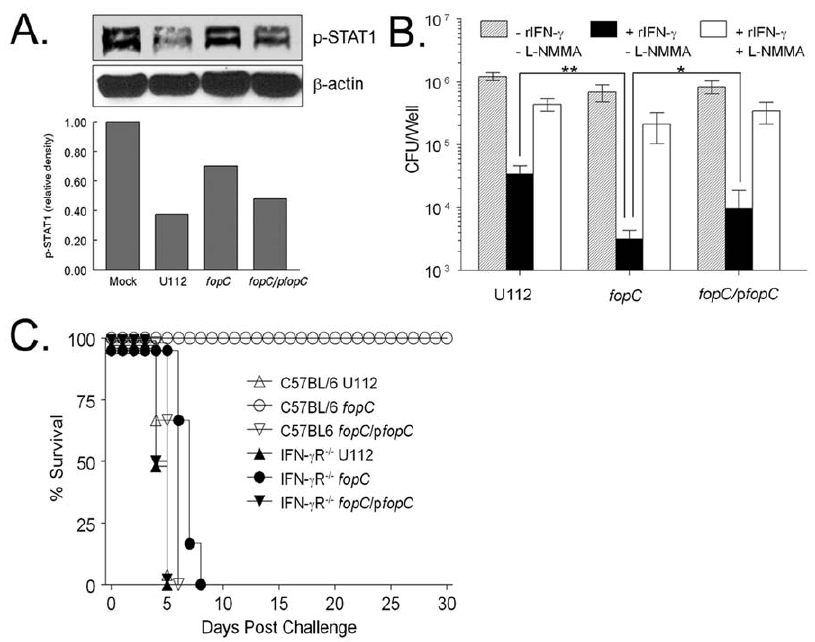
Figure 8. Virulence is restored in a fopC- complemented strain. (A) C57BL/6 macrophages (10 6 /well) were infected (10 MOI) with U112, fopC , or complemented fopC /p fopC strain in the presence or absence of rIFN- c (1 ng/ml) for 3 h. Protein-matched lysates from 3 h cultures were resolved by SDS PAGE and analyzed by Western blotting with phosphotyrosine-STAT1 and actin antibodies. The relative p-STAT1 levels of the three strains were first normalized with respective b -actin level and compared to mock treated p-STAT1. (B) Bone marrow derived primary macrophages (2 6 10 5 / well) from C57BL/6 or IFN- c R 2 / 2 mice were infected (10 MOI) with wildtype U112, fopC mutant or fopC /p fopC in the presence or absence of 1 ng/ml rIFN- c and 0.25 mM NOS inhibitor L-NMMA, and numbers of viable bacteria at 24 h determined by macrophage lysing and dilution plating. Results are expressed as the averages of values for three wells. Differences in bacterial replication within IFN- c activated macrophages between fopC mutant and U112** or fopC /p fopC * were significant at a p , 0.01** and p , 0.05*, respectively. (C) C57BL/6 and IFN- c R 2 / 2 mice (n=6/group) were challenged i.n. with 10 3 CFU U112, mutant fopC (KKF332) strain, or KKF332 strain complemented with p fopC ( fopC/ p fopC ). Difference in survival in challenged BALB/c mice between fopC mutant and complement strain was significant at a p , 0.001. All animals were monitored daily for survival for 30 days. (Representative of two-three experiments.)